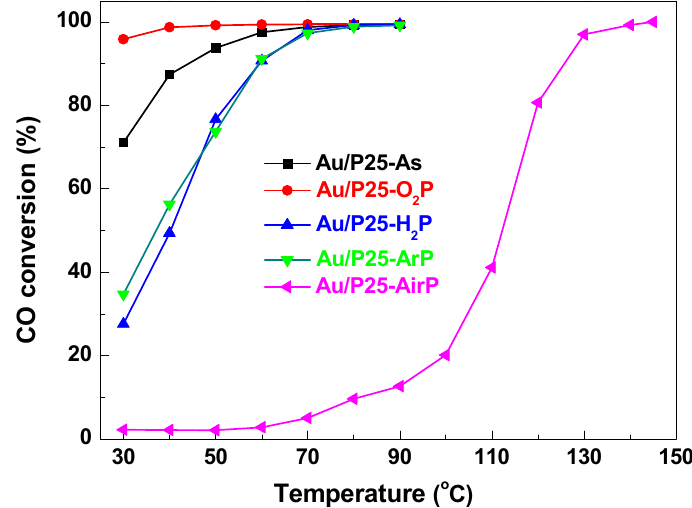
Figure 6. CO conversion over the Au/P25 catalysts activated by AP cold plasma using various working gases, as well as the as-prepared Au/P25-As.